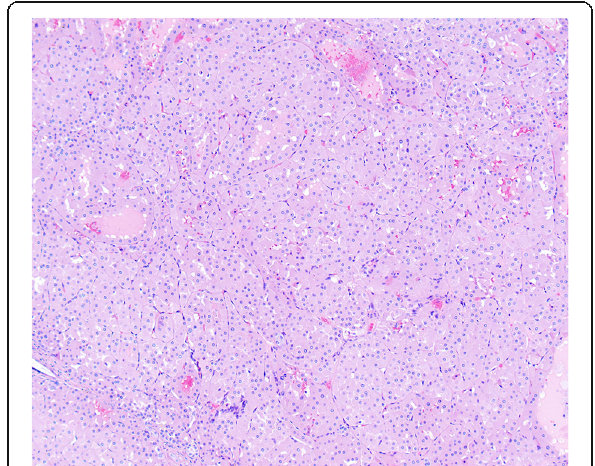
Fig. 1 Multifocal oncocytoma-like tumor associated with oncocytosis. The tumor is characterized by cells with bulky eosinophilic cytoplasm and low grade nuclei growing in a sheet-like pattern